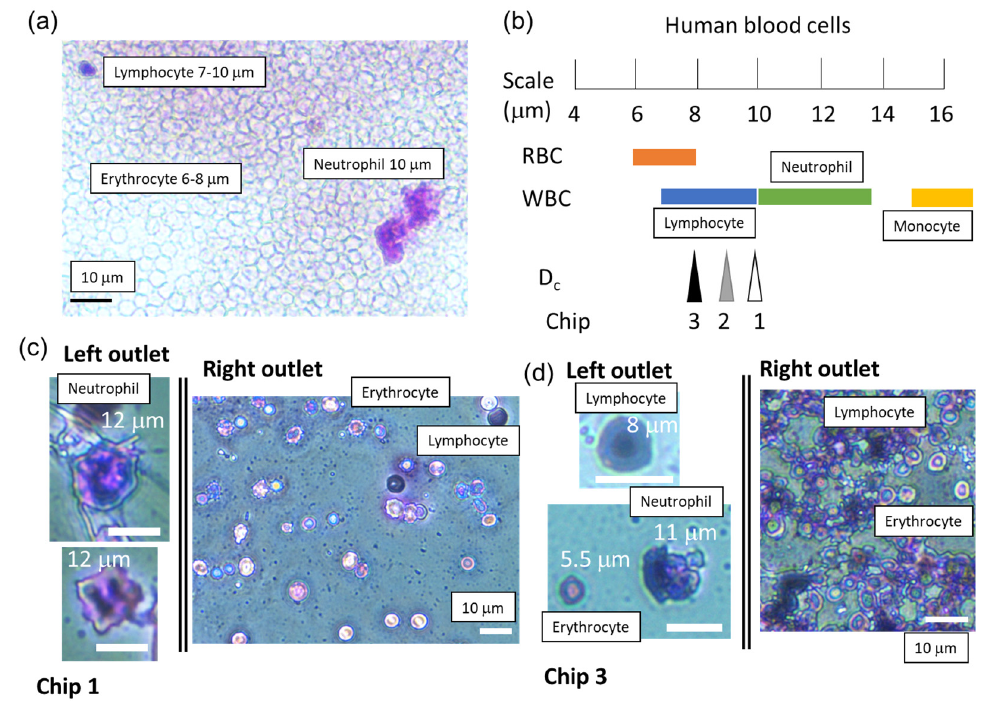
Figure 6. ( a ) A microscopic image of human blood cells before sorting. ( b ) Comparison of the diameters of human blood cells and D c values of the microfluidic DLD devices [35]. Microscopic images of collected human blood cells from left and right outlets using ( c ) Chip 1 and ( d ) Chip 3, respectively. The scale bars are 10 μm.